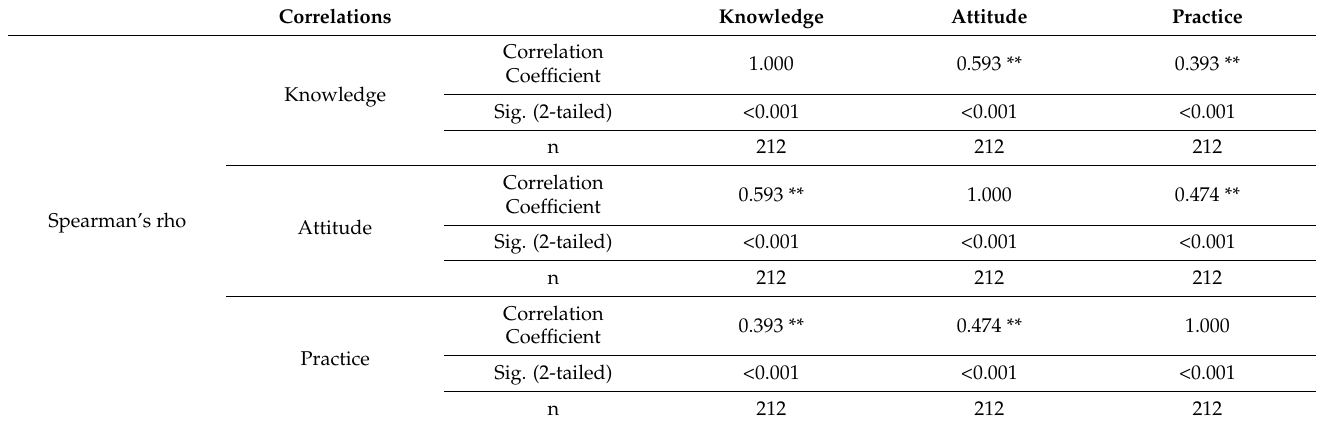
Table 4. Correlations among a farmer’s knowledge, attitudes, and practices towards AMU and